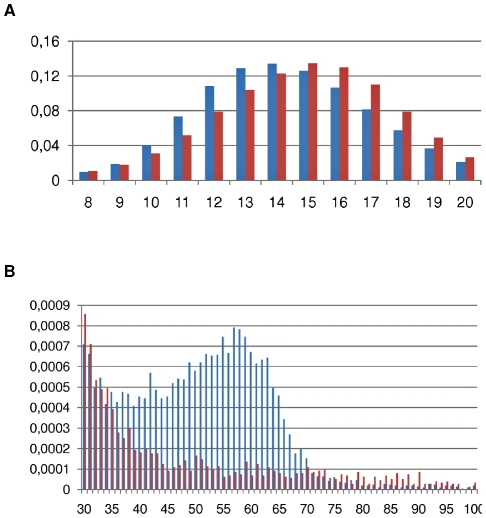
Distribution of hair diameters in µm (X-axis) in normal (blue) and rex (red) rabbit coats.Two diameter sizes ranges are represented on two different graphs to cope with the Y-axis scale (frequencies).